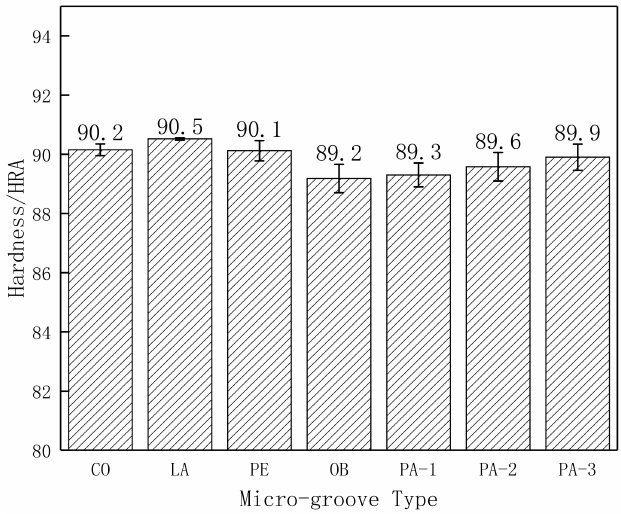
Figure 3. Hardness measurement results.